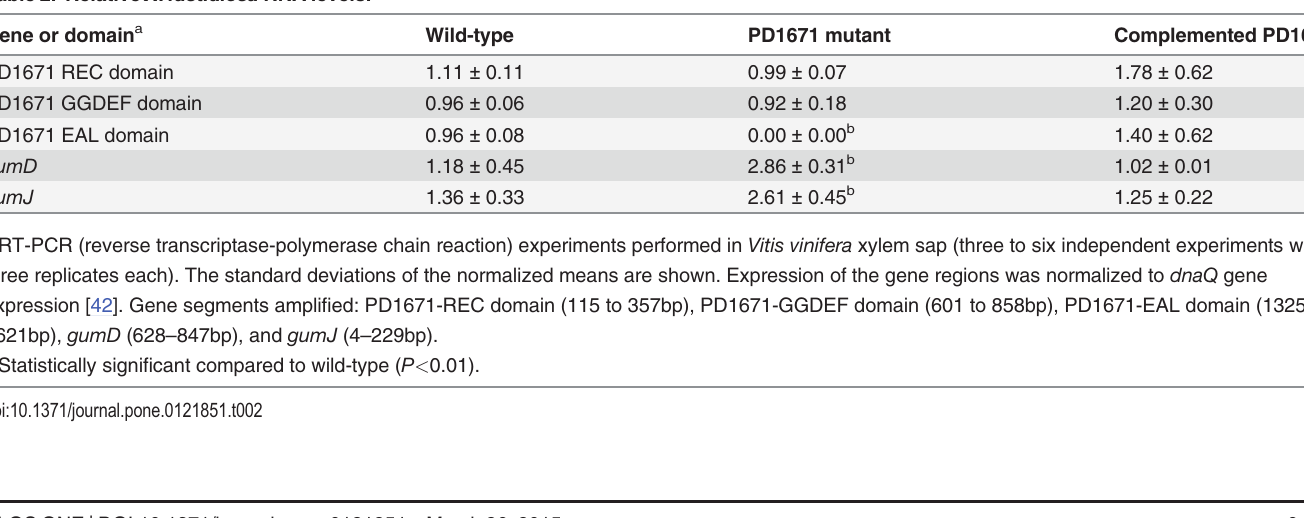
Table 2. Relative X . fastidiosa RNA